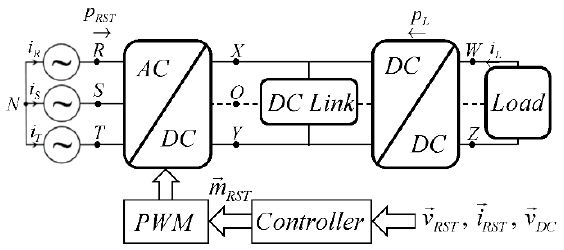
Figure 1. Generalized dual-stage power conversion system.